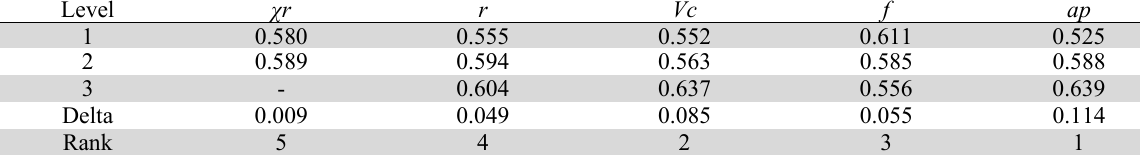
Mean of GRG ratio for each level of the machining parameters